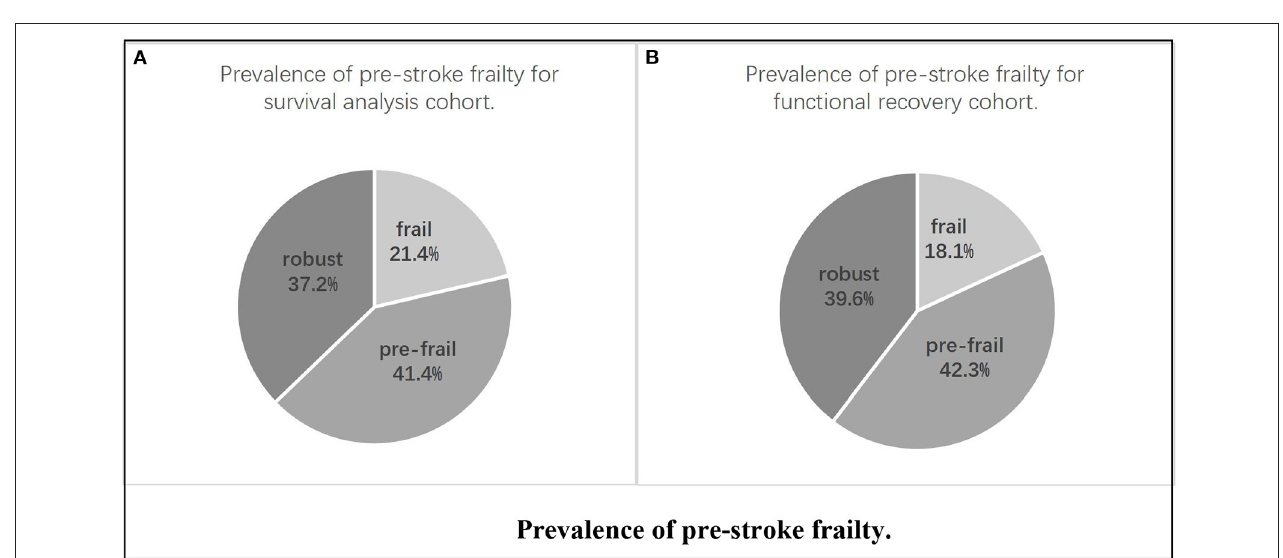
FIGURE 2 | Prevalence of pre-stroke frailty. (A) Prevalence of pre-stroke frailty for survival analysis cohort. (B) Prevalence of pre-stroke frailty for functional recovery cohort.